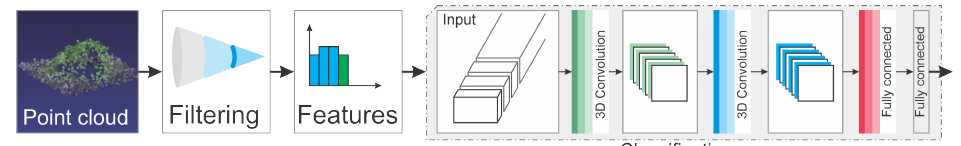
Figure 4. Proposed Neural Network Architecture for